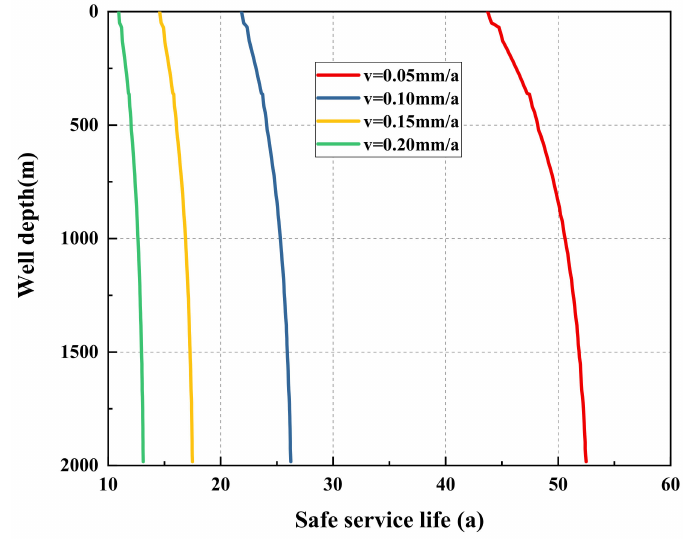
Figure 17. Influence of corrosion rate on the corrosion life of the inner layer of the string.